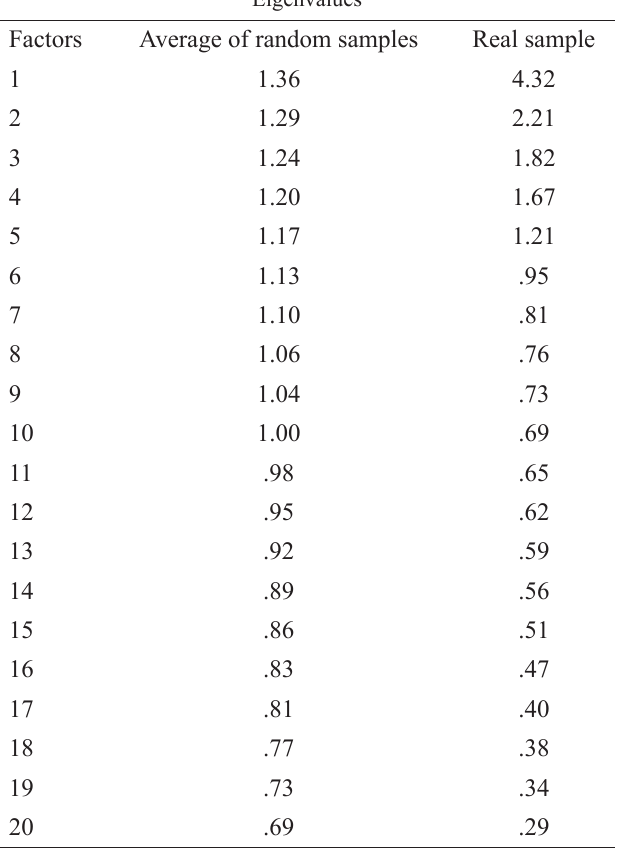
Table 2. Eigenvalues comparison between real and dummy